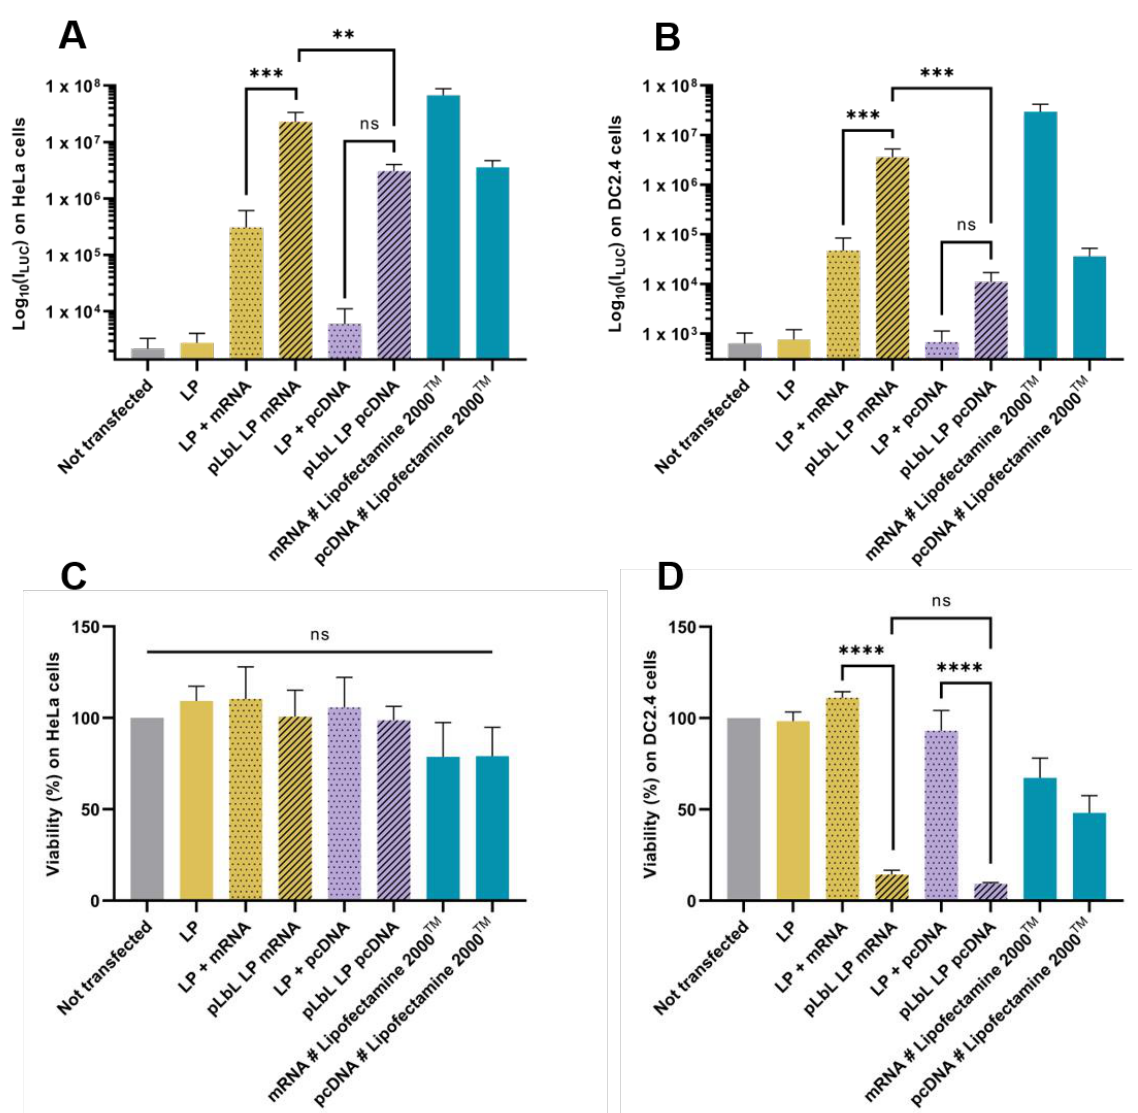
Figure 6. In vitro evaluation at +24 h (top) of transfection efficiency through the measurement of luminescence intensity (Bright-Glo luciferase assay) and (bottom) cell viability (PrestoBlue assay) obtained after transfection of 90 ng eq . of either Fluc mRNA or luciferase-pcDNA3.1, formulated in LP using pLbL strategy (ratio nucleic acids/LAH4-L1 = 1:20 w / w ) on HeLa ( A , C ) and DC 2.4 ( B , D ) cells. Lipofectamine 2000 TM was used as positive control. Data are presented as mean ± SD and statistically analyzed using one-way ANOVA followed by Tukey’s multiple comparison test (ns: p > 0.01, **: p <0.001, ***: p < 0.0001 and ****: p < 0.00001).